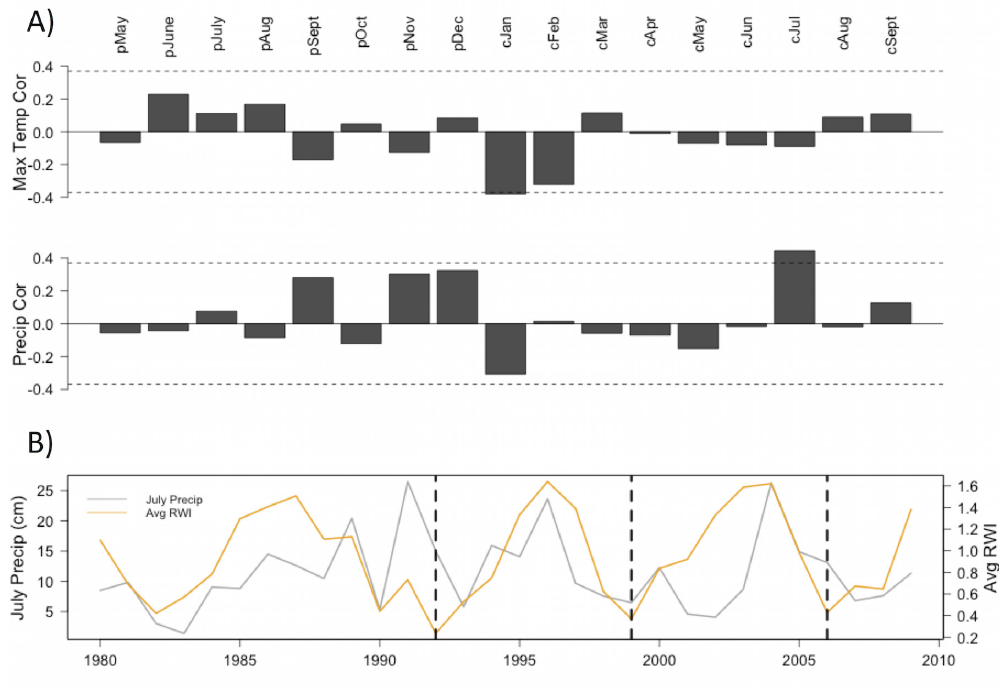
Fig 6. Climate response. (A) Correlations between monthly maximum temperature/monthly precipitation and average ring-width index from all seed sources combined. Pearson correlation coefficients were computed from 1980 – 2009 and the years 1992 – 1994 were not included. The dashed lines denote the 95% confidence limit (2-tailed test). (B) Comparison between July precipitation (gray) and average ring width (orange) index from 1980 – 2009, with dashed lines indicating major missing ring